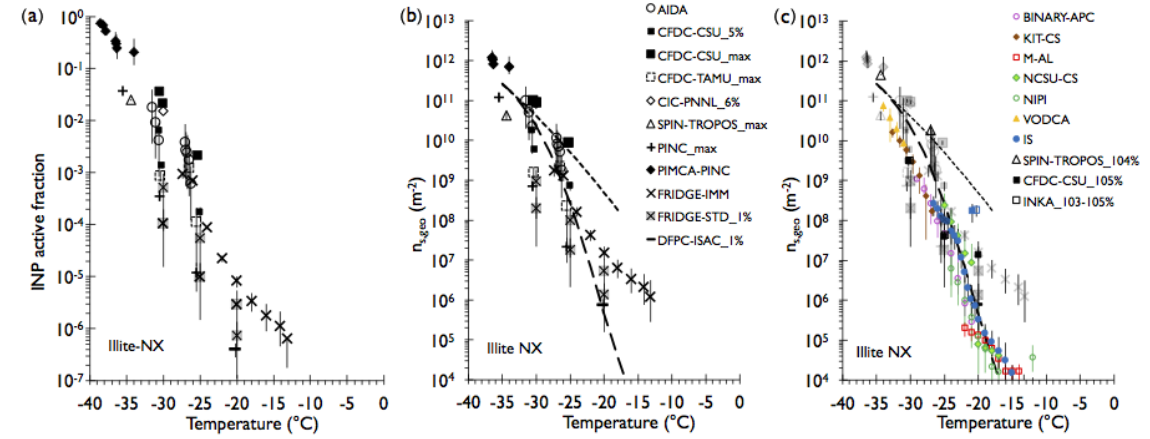
Figure 8. (a) Ice active fraction from multiple experiments performed on illite NX aerosols sampled directly from the AIDA chamber prior to expansion cloud experiments. In these cases, the subsequent AIDA measurements of activated ice crystal concentrations are included for comparison when water supersaturation was achieved during the expansion cycle. Instrument symbols are shown in panel (b) . (b) Conversion of data to the geometric surface active site density parameter, n s , geo using AIDA aerosol distribution data, and data within Table 3. Where specific instrument water supersaturations were selected for comparison, these are indicated after the instrument label (e.g., CIC-PNNL_6% implies 106% RH w ) . The term “max” means the highest RH w achieved in a scan (102%–110%), as listed in Table S1. FIN-02 AIDA experiments (unnumbered, 11 March 2015), 4 (16 March 2015), 10 (19 March 2015), 22 (26 March 2015), and 25 (27 March 2015) are represented. Gumbel cumulative distribution (log-space) fit curves for illite NX are from Hiranuma et al. (2015; cf., Table 3), representing wet suspension (long-dashed) and dry-dispersion experiments (short-dashed) in that study. (c) Wet suspension (colored points) and flow chamber (black points) n s , geo data derived from APC experiment 7 (16 March 2015) for all instruments listed in the legend are overlain on greyed-out AIDA experiment points from panel (b) . Additional CFDC-CSU and INKA data points from APC experiment 3 (13 March 2015) are included as blue data points for these